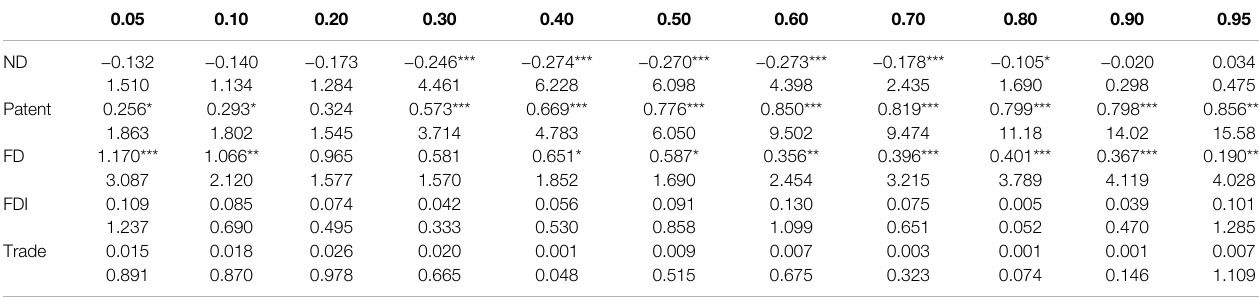
TABLE 4 | Panel quantile regression of economic growth. 0.05